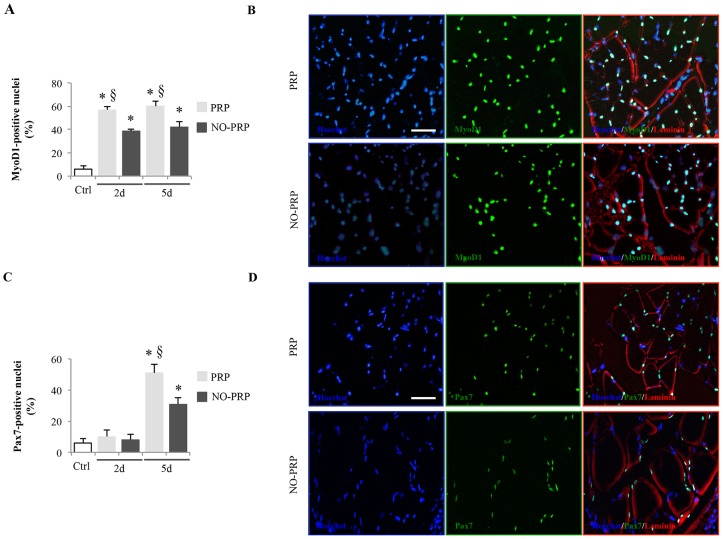
Immunohistochemical analysis of (A) MyoD1-positive or (C) Pax7-positive nuclei in skeletal muscle injury treated or not with PRP.Representative double-immunoflorescence staining of skeletal muscle for (B) MyoD1 (green) and laminin (red) or (D) Pax7 (green) and laminin (red), at day 2- and 5, respectively. Myonuclei were counterstained by blue fluorescent dyes (Hoechst). The percentage of MyoD1-positive or Pax7-positive cells was calculated as the ratio of the number of nuclei in MyoD1- or Pax7 positive cells over that of Hoechst-positive nuclei. Results were presented as means ± SEM from n = 5 rats/group per time point and on five sections from each animal. Scale bars  = 50 µm. * p<0.05 vs. Ctrl group. §
p<0.05 vs. NO-PRP group.